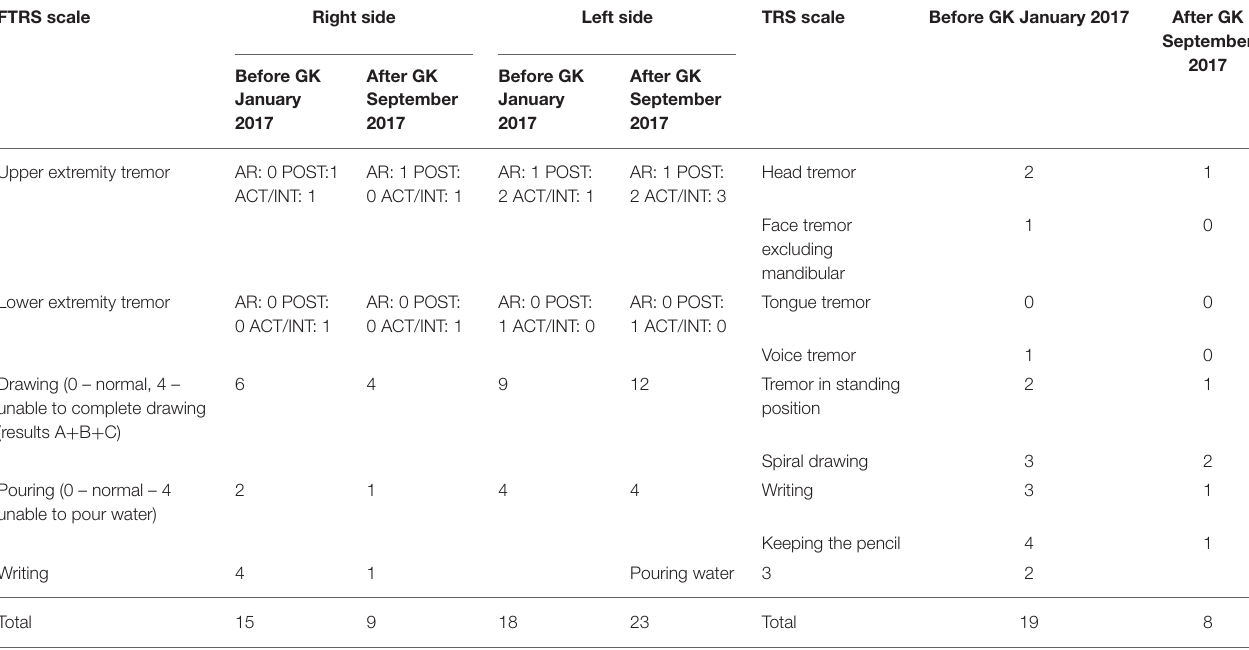
TABLE 1 | Fahn-Tolosa-Marin Tremor Rating Scale (FTRS) motor score and Tremor Rating Scale (TRS) changes. FTRS scale Right side Left side TRS